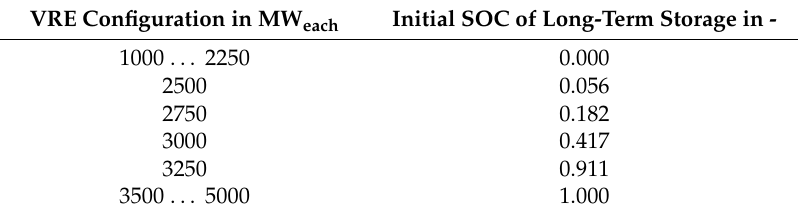
Table 2. Initial storage SOC depending on rated power of installed